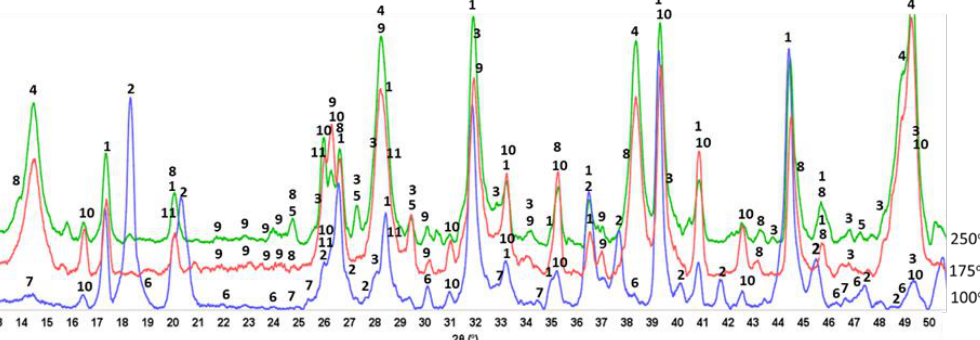
Figure 9. XRD patterns for 100-, 175-, and 250 °C-autoclaved CaP/FCS cements: 1-katoite (00-024-0217/01-077-0240/01-084-01354/01-074-9779); 2-gibbsite (01-076-1782); 3-hydroxyapatite (04-016-1647/04-011-6221/01-074-9779); 4-boehmite (04-010-5683); 5-calcium carbonate (01-085-6719); 6-krotite (00-023-1037); 7-grossite (00-023-1037); 8-hydrosodalite (00-040-0102); 9-albite (01-089-6427); 10-mullite (04-016-1586); and 11-silicon oxide (00-014-0654).